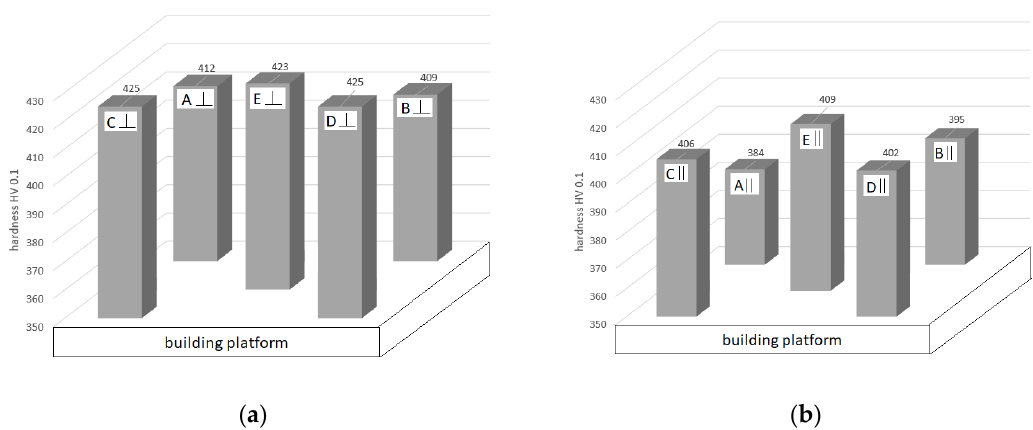
Figure 15. Distribution of hardness in strategic positions on the build platform in ( a ) ⊥ and ( b ) ‖ directions.